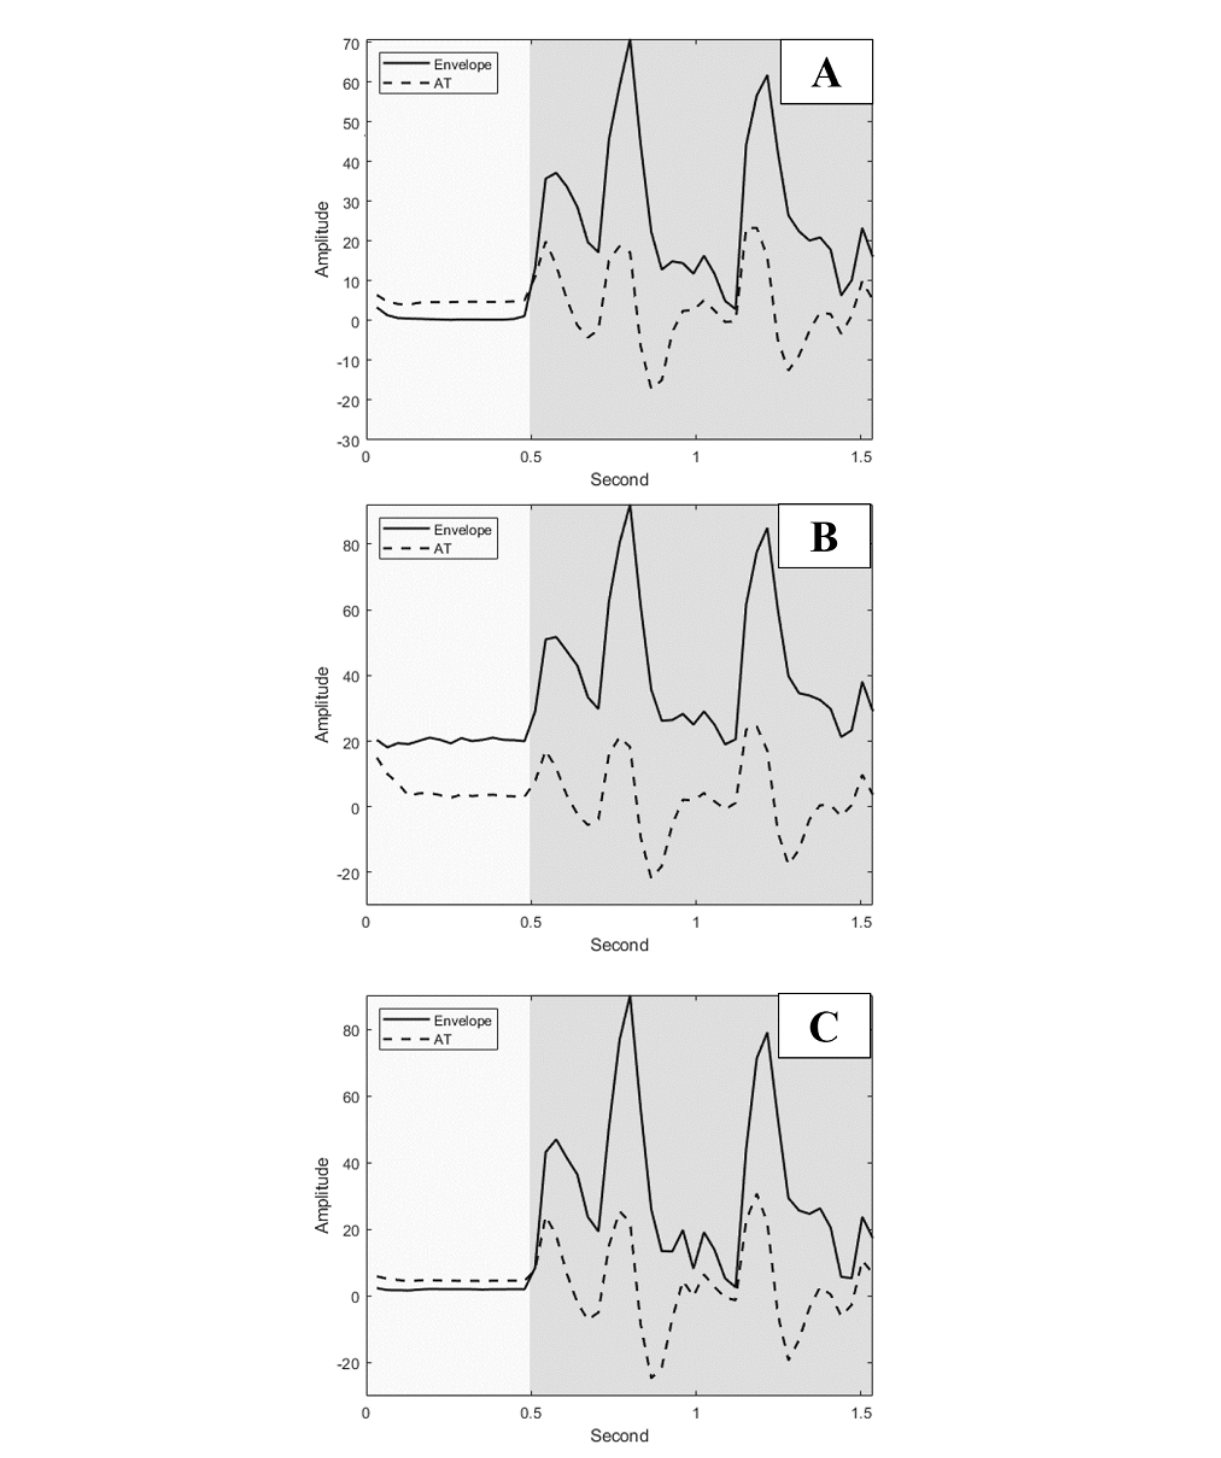
Figure 10. Example of the relationship between the speech envelope and AT in (A) the controlled environment, (B) noisy conditions without the noise reduction function, and (C) noisy conditions with the noise reduction function. Each part of the figure presents the same speech; the gray background denotes the speech segments, while the other areas indicate the nonspeech segments. AT: adaptive